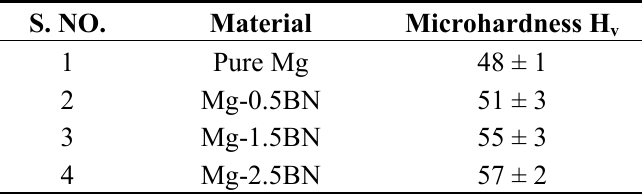
Table 4. Results of microhardness measurements.